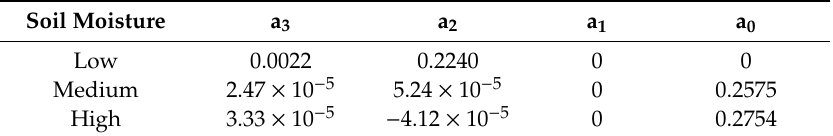
Table 4. Coefficient a i in Equation (3).